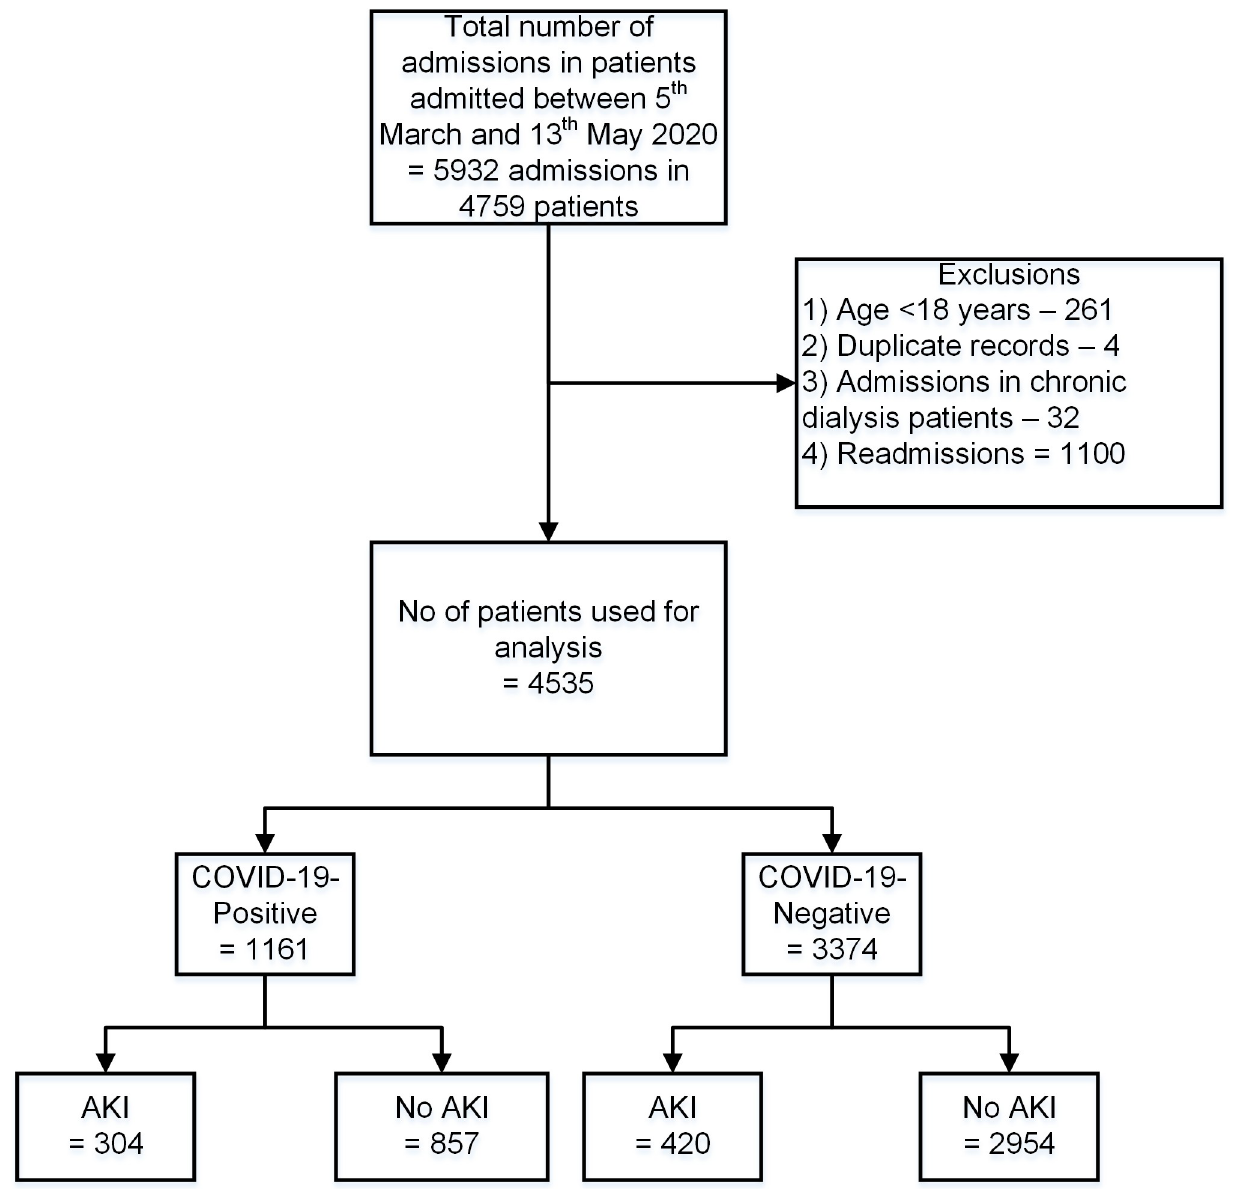
Fig 1. Study flowchart showing the number of participants involved at each stage of the study. AKI, acute kidney injury; COVID-19, Coronavirus Disease 2019. (7.1% versus 15.8%, p < 0.001), CCF (12.7% versus 27.0%, p < 0.001), PVD (3.1% versus 10.3%, p < 0.001), dementia (9.3% versus 22.7%, p < 0.001), chronic lung disease (23.2% versus 33.2%, p < 0.001), diabetes with complications (19.1% versus 27.0%, p = 0.002), chronic liver disease (0.7% versus 2.9%, p < 0.01), CKD (12% versus 32.2%, p < 0.001), and cancer (5.4% versus 9.8%, p = 0.006). COVID-19 patients who died were also more likely to have developed AKI (16.2% versus 43.9%, p < 0.001). We performed multivariable logistic regression analysis to identify independent predictors of mortality in COVID-19. Higher age-group (age-group 65 to 84 years: OR 3.47, 95% CI 2.27, 5.3; age-group � 85 years: OR 4.33, 95% CI 2.62,7.16), male sex